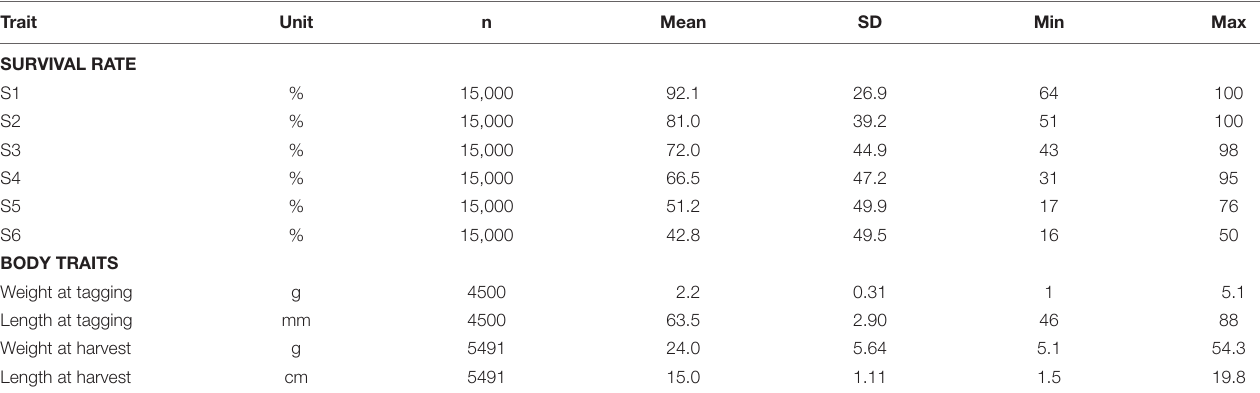
Different superscript letters in a column show statistical difference with P < 0.05. TABLE 2 | Number of observations (n), mean, standard deviation, minimum, and maximum survivals over six different experimental periods. Trait Unit SURVIVAL